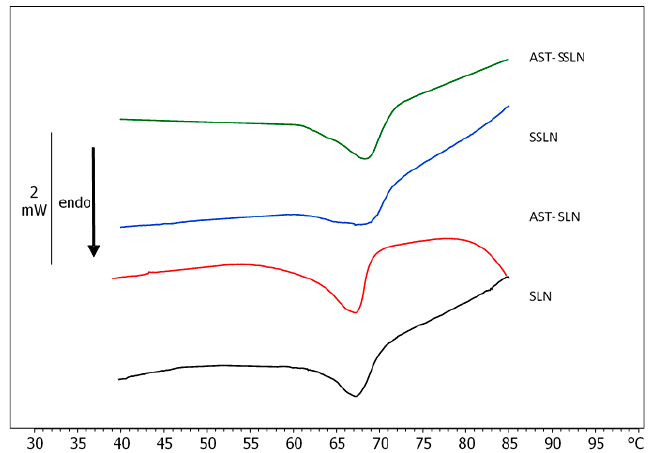
Nanomaterials 2021 , 11 , x FOR PEER REVIEW Figure 5. Calorimetric curves in heating mode, of SLN and SSLN unloaded and loaded with AST.